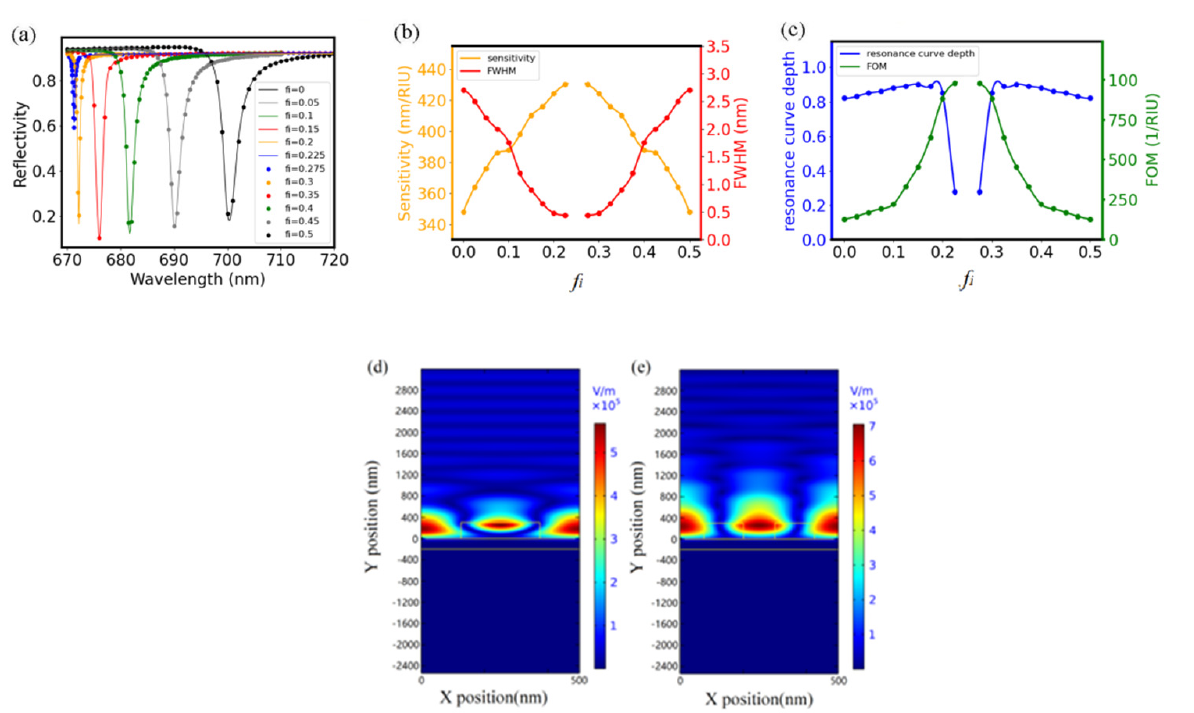
Figure 2. ( a ) Reflection spectrum of MADG based GMR sensor with f i ranging from 0 to 0.5 for the normal incident TE polarized light (electric field perpendicular to the plane of incidence light with normal direction of interface). ( b ) Dependence of sensitivity and FWHM of MADG based GMR on f i . ( c ) Dependence of FOM and resonance curve depth on fi . ( d ) Electric field distribution of GMR with f i = 0 and with ( e ) f i = 0.2. For simulation, Λ was set at 500 nm, H g at 300 nm, H m at 100 nm, and fill factor f at 0.25.